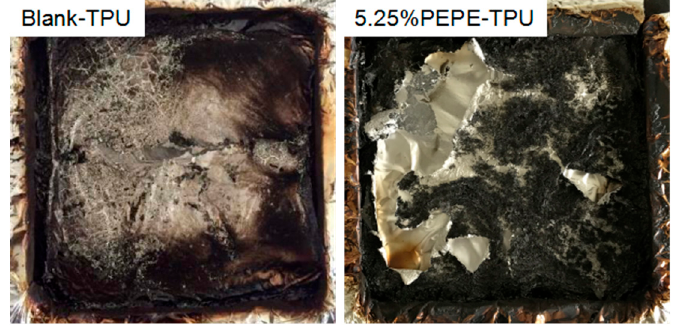
Figure 3. Combustion test curves of TPU with PEPE; ( a ) HRR and ( b ) THR.